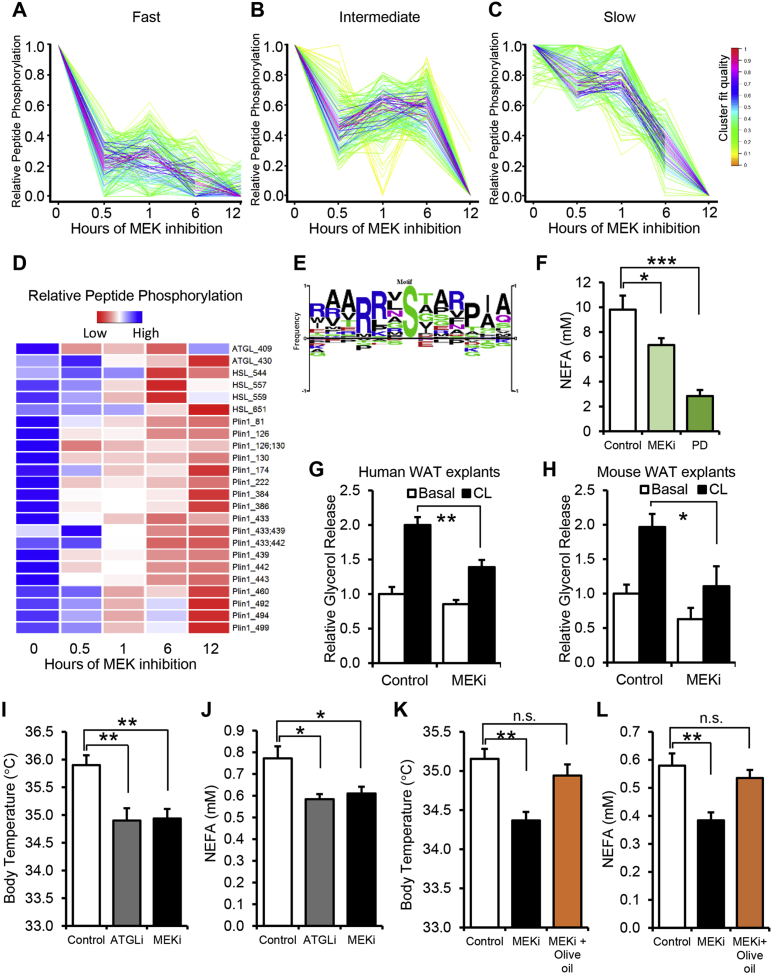
MEK inhibition impairs β3AR signaling, lipolysis and thermogenesis. (A–C) Temporal clustering of quantitative mass spectrometry on WAT phosphopeptides from diet induced obese mice following MEKi treatment for 0, 0.5, 1, 6 or 12 h (mean of n = 2 per group). Each line represents a unique peptide; line color represents how well a peptide fits within the cluster. (D) Heat map of peptides' relative phosphorylation from proteins controlling adipocyte lipolysis. (E) Sequence logo from peptides in 2D showing a PKA consensus phosphorylation motif (RRxS). (F) Non-esterified fatty acid (NEFA) levels in plasma fom obese mice treated with MEK inhibitors Trametinib (MEKi) or PD0325901 (PD) (n = 7–9 per group) (G) Effect of MEKi on adipose tisse explants from human subcutaneous adipose tissue in a glycerol release assay. (H) Effect of MEKi on adipose tissue explants from mouse inguinal WAT in a glycerol release assay (I) Core body temperature measured by subcutaneous telemetry probes and (J) NEFA in mice treated with saline (Control), ATGL inhibitor (ATGLi) or MEKi during a 4 °C cold temperature challenge. (K) Core body temperature and (L) NEFA in mice treated with vehicle (Control), MEKi, or MEKi and exogeneous fatty acids (Olive oil) during a 4 °C cold temperature challenge (n = 8 per group). Error bars represent SEM. Statistical significance was analyzed by one-way ANOVA n.s., р > 0.05; *, р < 0.05; **, p < 0.001; ***, p < 0.005.